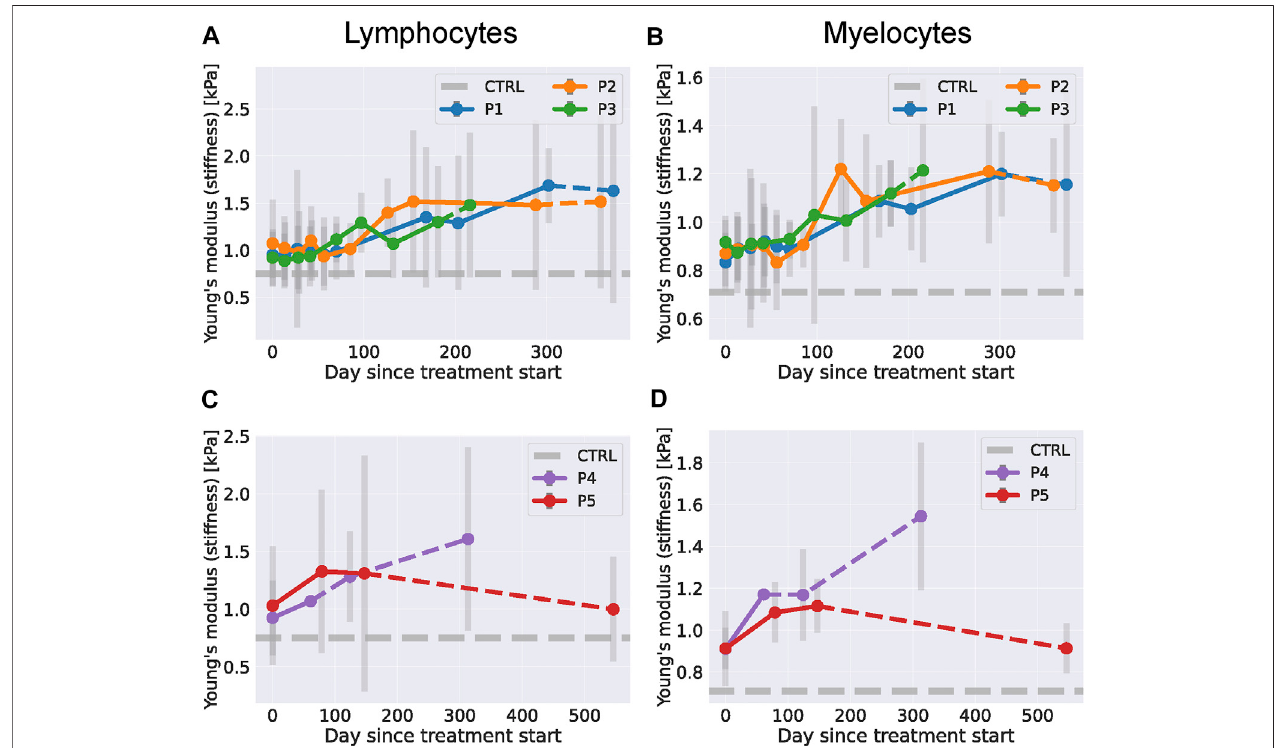
FIGURE 5 | Leukocyte stiffness in RT-FDC during treatment with dasatinib or lithium. (one column fi gure) (A) Median Young ’ s modulus of ChAc patients ’ lymphocytes during dasatinib treatment. (B) Median Young ’ s modulus of ChAc patients ’ myelocytes during dasatinib treatment. (C) Median Young ’ s modulus of ChAc patients ’ lymphocytes during lithium treatment. (D) Median Young ’ s modulus of ChAc patients ’ myelocytes during lithium